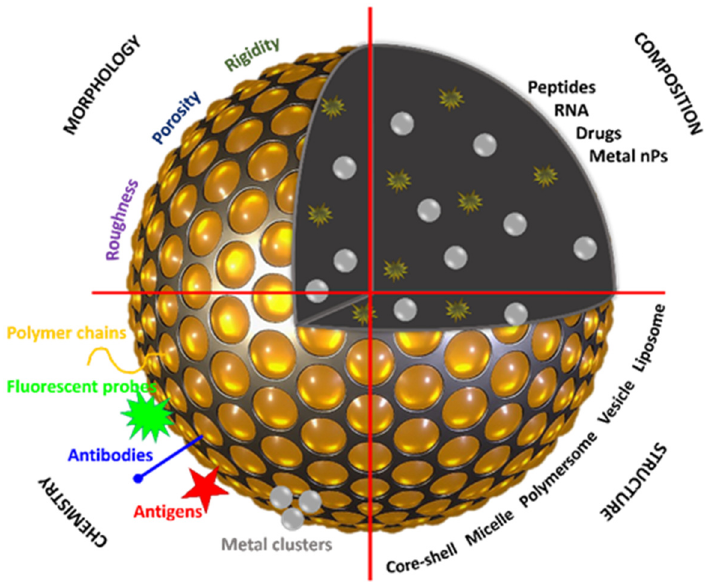
Figure 2. Schematic of the versatility of PNPs in cancer diagnostic, imaging and therapy.